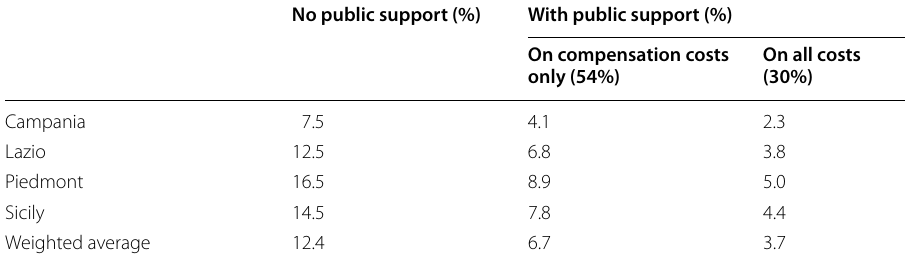
Table 5 Minimum contribution rate to make the MF economically sustainable—without and with public support